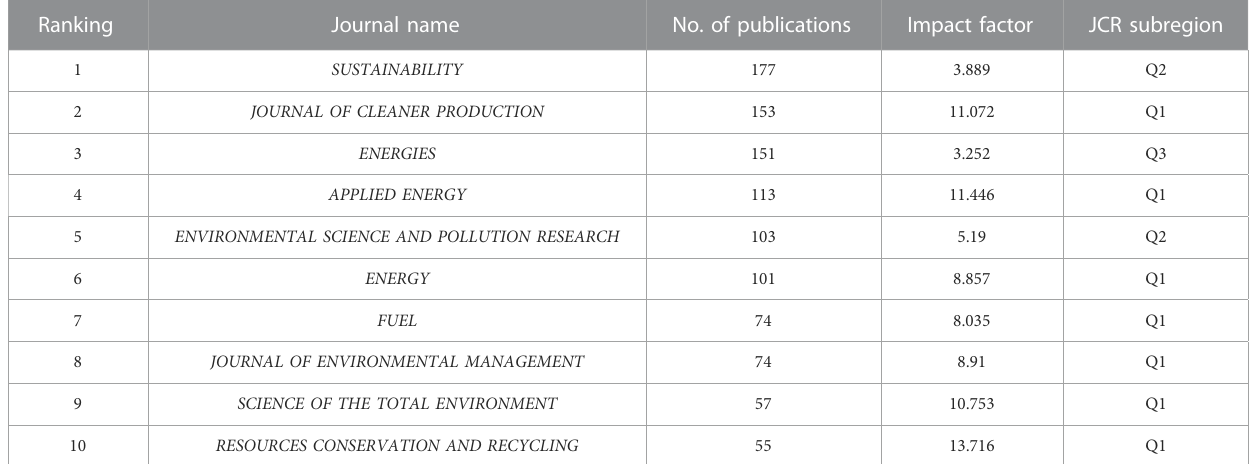
TABLE 2 Top 10 international journals in terms of the number of